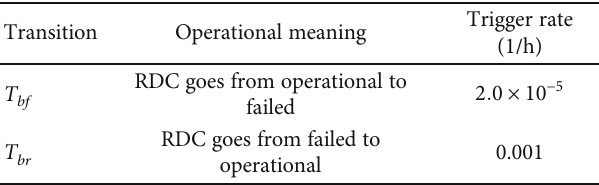
Figure 8: FTGPN model of the IMA system. Table 6: Transitions in the GSPN model for